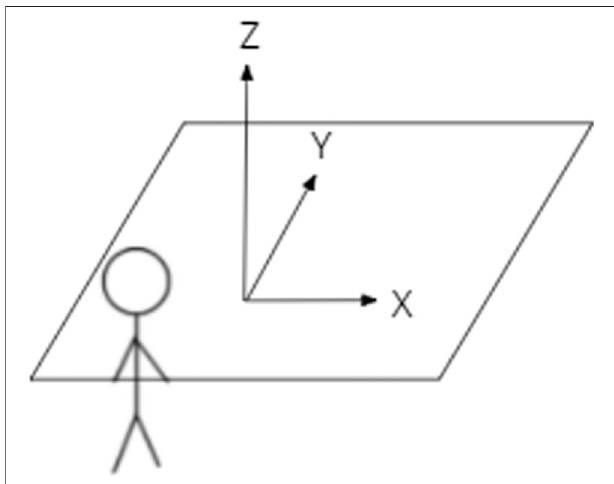
FIGURE 4 | Direction of axes of motion relative to